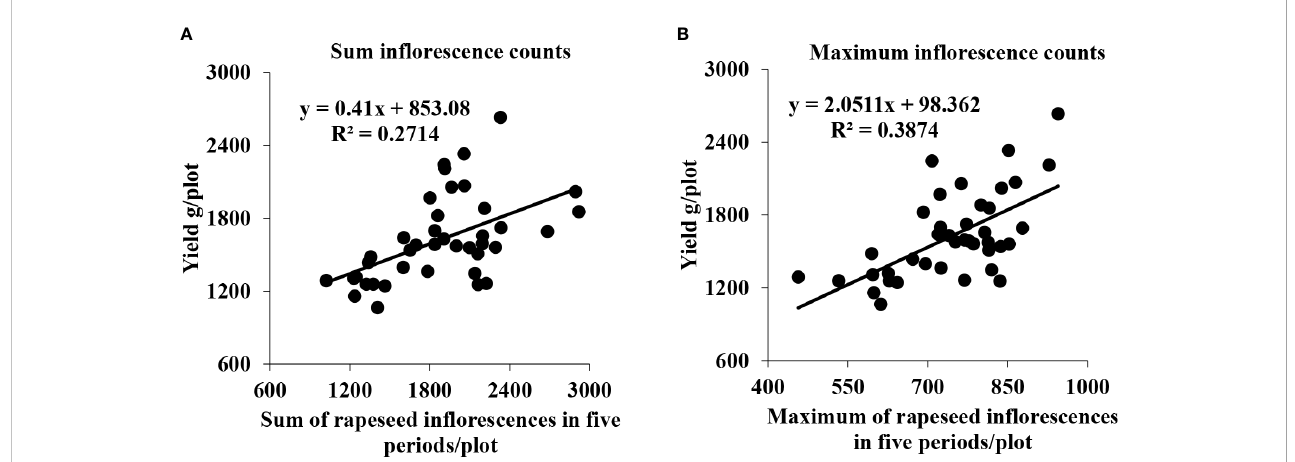
in fl orescences of each plot in fi ve periods.